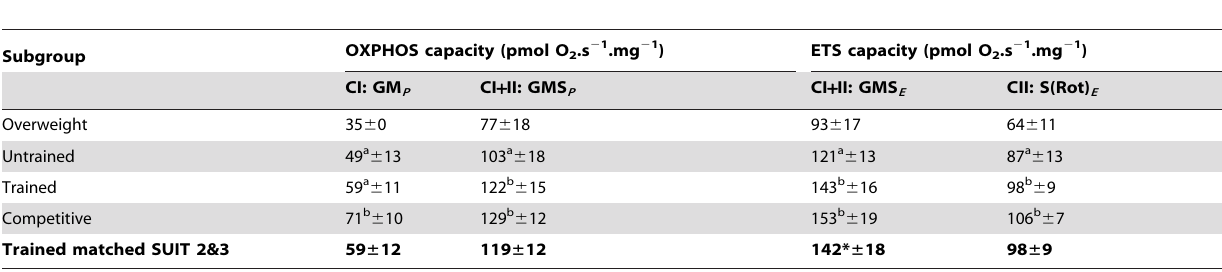
Table 2. Respiratory parameters from substrate-uncoupler-inhibitor titration protocol 1 (SUIT1) applied on equine permeabilized fibres of triceps brachii : OXPHOS and ETS capacities according to fitness level ( N =32).